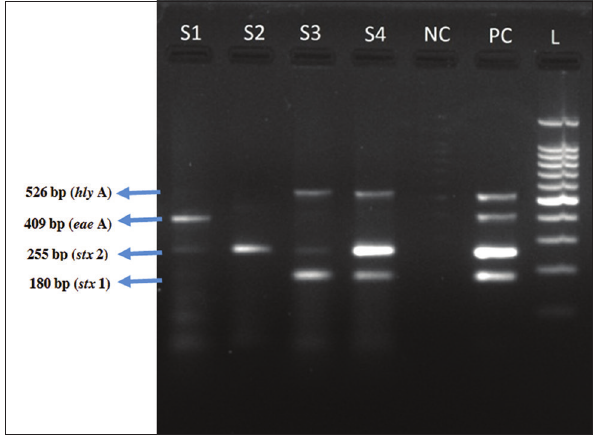
Figure-1: Multiplex polymerase chain reaction. S1-S4: Enterohemorrhagic Escherichia coli (EHEC) isolates from samples, NC: Negative control, PC: Positive control (EDL 933 strain of EHEC), L-100 bp ladder (180 bp – stx 1, 255 bp – stx 2, 409 bp- eae A, and 526 bp – hly A gene). Table-1: Primer sequences and their respective product sizes.